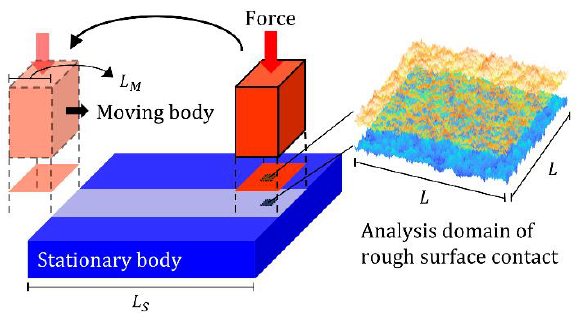
Figure 1. Schematic of periodic sliding motion between a lower stationary body and an upper moving body under constant normal force.